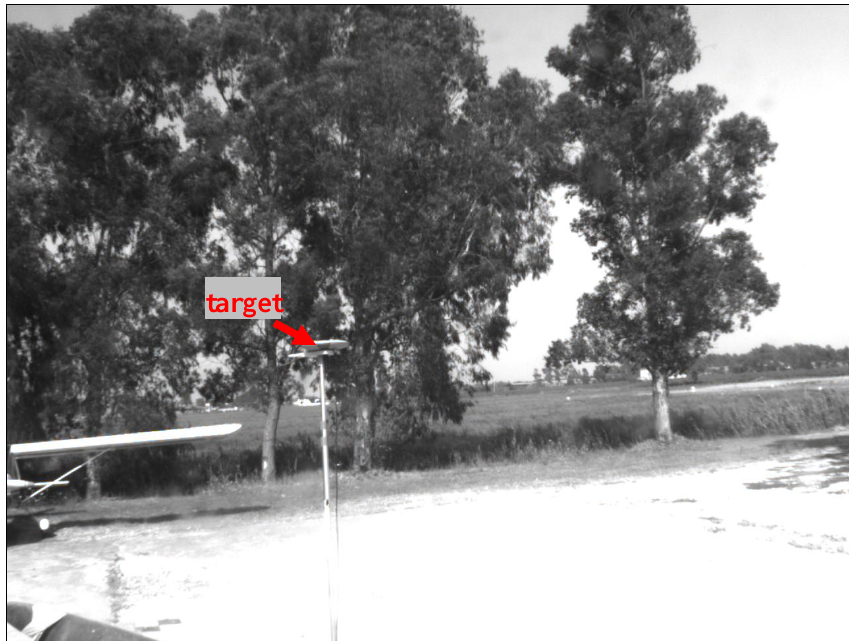
Figure 5. Example of panchromatic image taken during the alignment session.